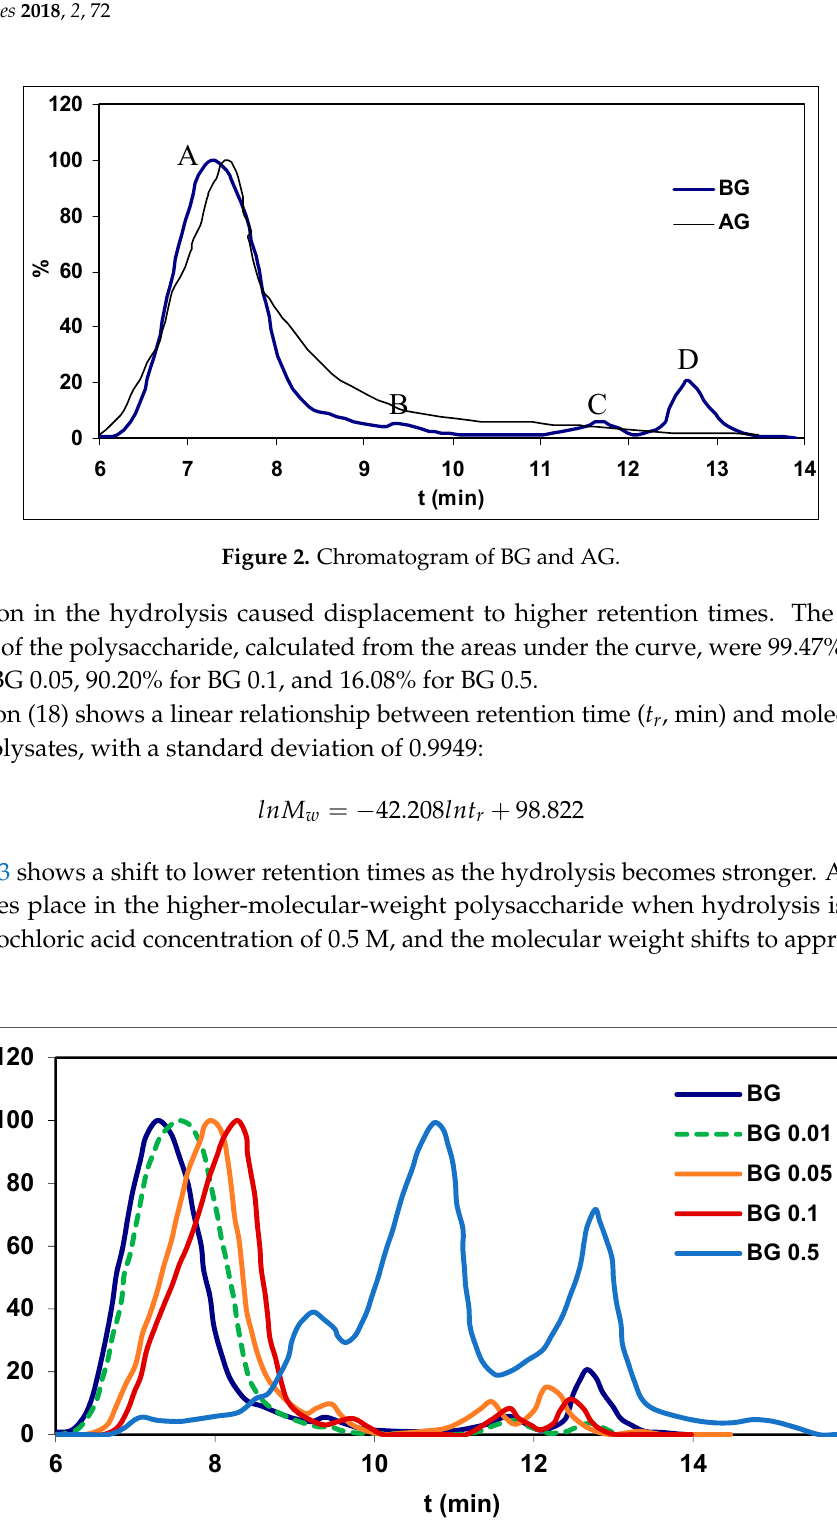
Figure 3. SEC chromatogram of BG hydrolysates.